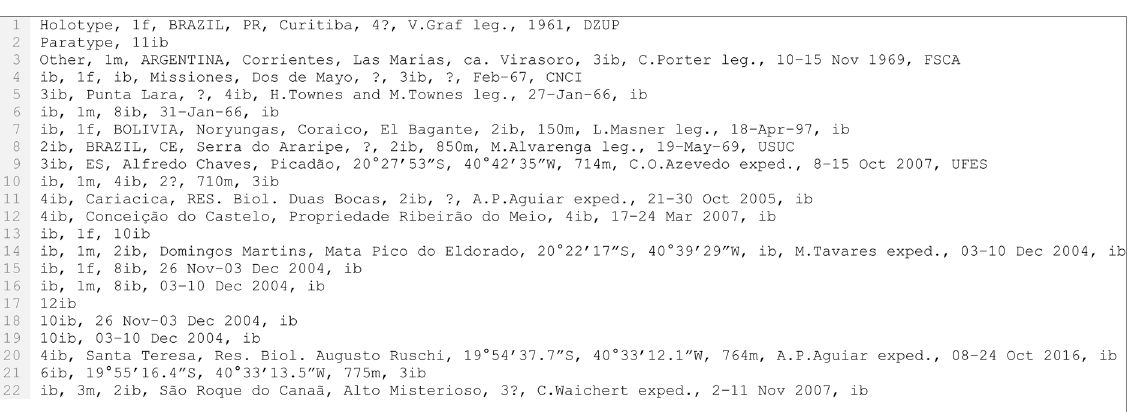
Table 2. Example of Material Examined text structured strictly with the grid-setting technique, as proposed in this work. Generated by grouping the collecting events (lines in the text in Fig. 5) in a single paragraph, separating each event with a bullet point. Selected variables highlighted in bold; m and f codes replaced by the respective male and female